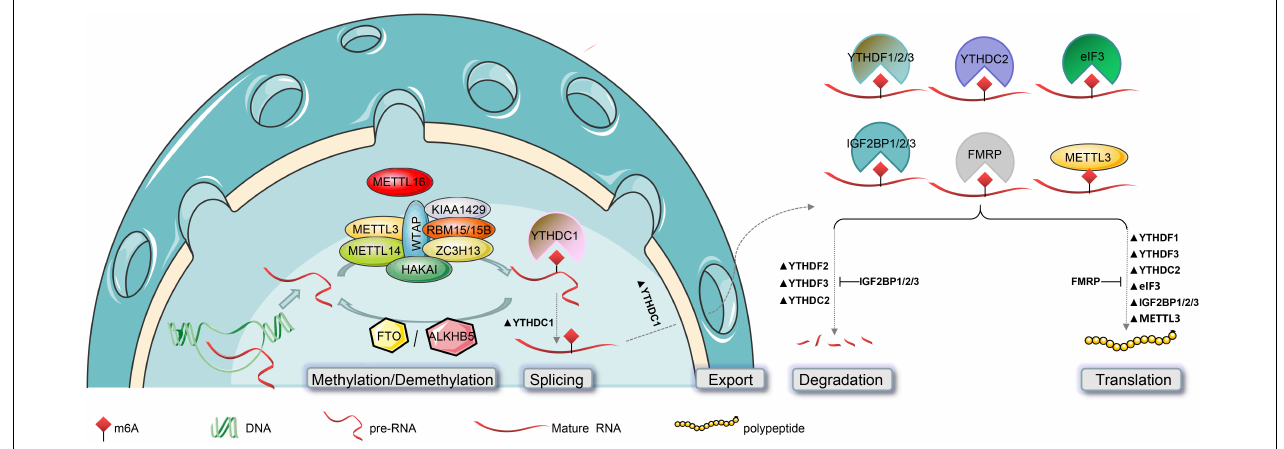
FIGURE 2 | Post-transcriptional modification of RNA by m 6 A and its functions. The biogenesis of m 6 A in the mammalian nucleus is catalyzed by the methyltransferase complex (composed of METTL3, METTL14, WTAP, KIAA1429, RBM15/15B, ZC3H13, and HAKAI) or METTL16, and is reversed by m 6 A-demethylase (FTO or ALKBH5). The functional effects of m 6 A on RNAs can affect their nuclear splicing, nuclear export, stability, and translation efficiency. This is mediated by m 6 A “Readers,” such as YTHDC1 in the nucleus, and YTHDF1/2/3, YTHDC2, eIF3, IGF2BP1/2/3, and FMRP in the cytoplasm. Notably, in addition to catalyzing m 6 A methylation, METTL3 also directly promotes RNA